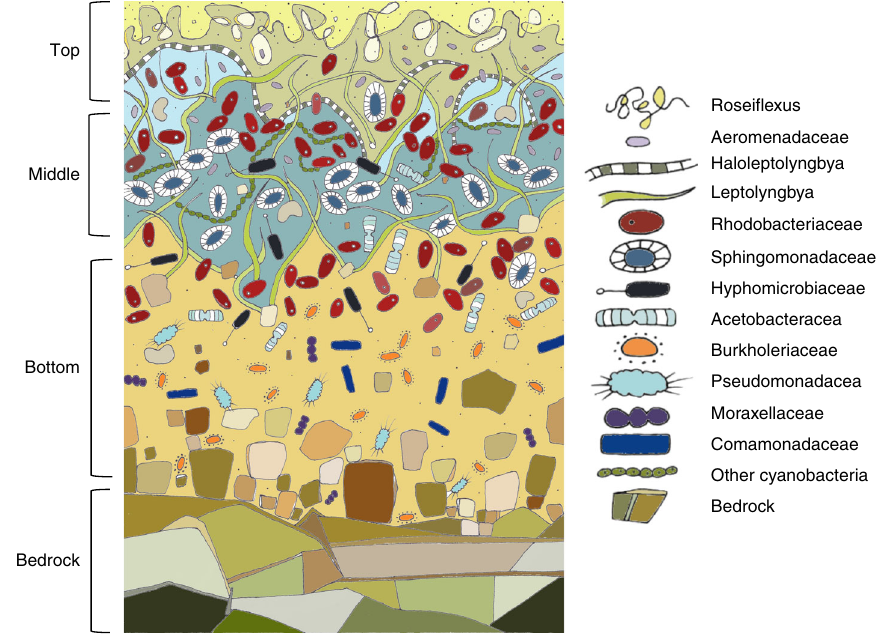
Fig. 2 Stylized illustration of Balambano microbial mat. The illustration depicts the positions of major microbial taxa, weathered rock fragments, and underlying bedrock. Cells not drawn to scale